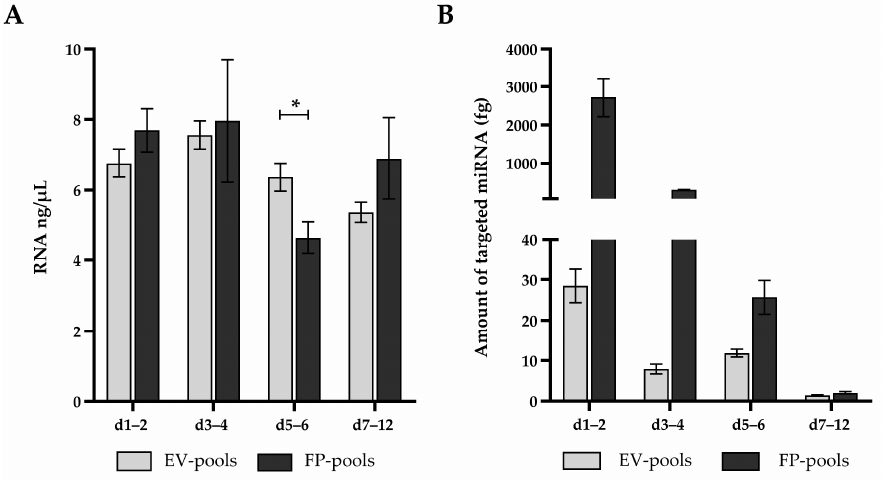
Figure 5. Targeted microRNAs (miRNAs) are present in extracellular vesicles (EVs) and free pro- teins (FPs) separated from cerebrospinal fluid (CSF), but only as a small portion of detected RNA. ( A ) miRNA was isolated from indicated CSF pools after they were separated by size exclusion chromatography (SEC) to EVs and FPs. RNA concentration was determined by spectrophotometric measurement. Mean values and standard deviations from two measurements are shown. * p = 0.008 by unpaired t-test. ( B ) Targeted miRNAs were quantified in EV- and FP-pools obtained after SEC, followed by a PCR-array and absolute quantification. Detected miRNA amounts were summed for each indicated time point. Mean values and standard deviations from two measurements are shown. Table 2. Enrichment of targeted microRNAs (miRNAs) in free protein (FP)- and extracellular vesicle (EV)-pools from cerebrospinal fluid (CSF) of patients with severe traumatic brain injury. miRNAs enriched in both EV- and -FP-pools are